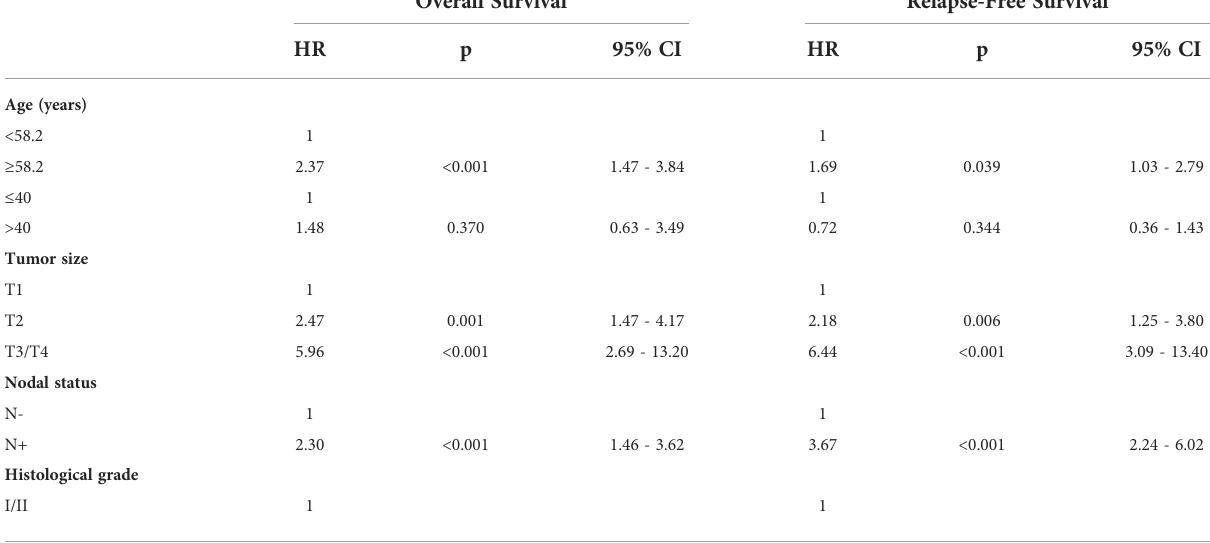
TABLE 3 Univariate analysis of clinicopathological variables associated with relapse-free survival and overall survival. Overall